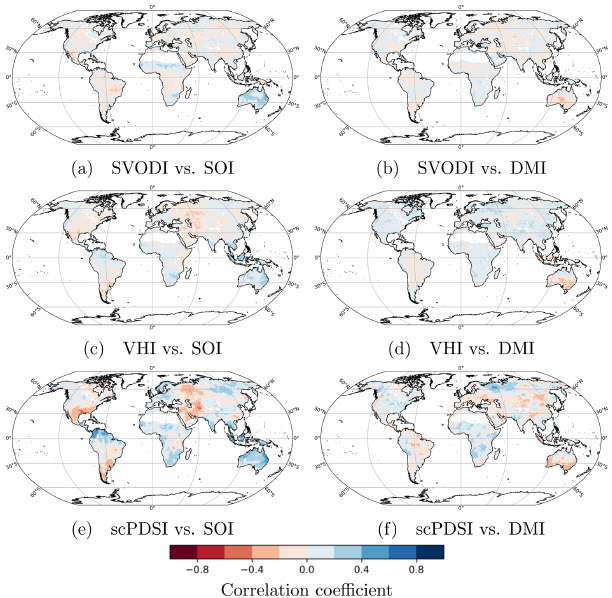
Figure 12. Correlation coefficients between SVODI, VHI and scPDSI (top to bottom) vs. SOI (a, c, e) and DMI (b, d, f) .